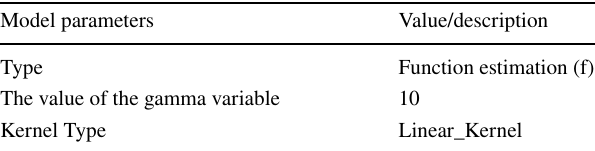
Table 2 Parameters used in SVR modeling